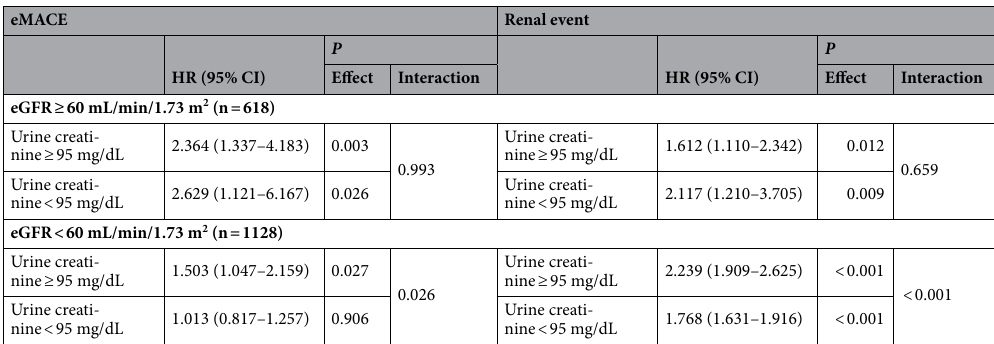
Table 4. Adjusted hazard ratios of per SD-unit increase in urine protein-creatinine ratio (UPCR) for extended major adverse cardiovascular events (eMACEs) and renal events stratified by urine creatinine concentration across the whole study population. HR hazards ratio, CI confidence interval, UPCR urine protein-creatinine ratio, eMACE extended major adverse cardiovascular event. *Adjusted for age, sex, BMI, smoking, previous CVD, diabetes, hypertension, glomerulonephritis, baseline eGFR, and use of RAS blocker and statin.